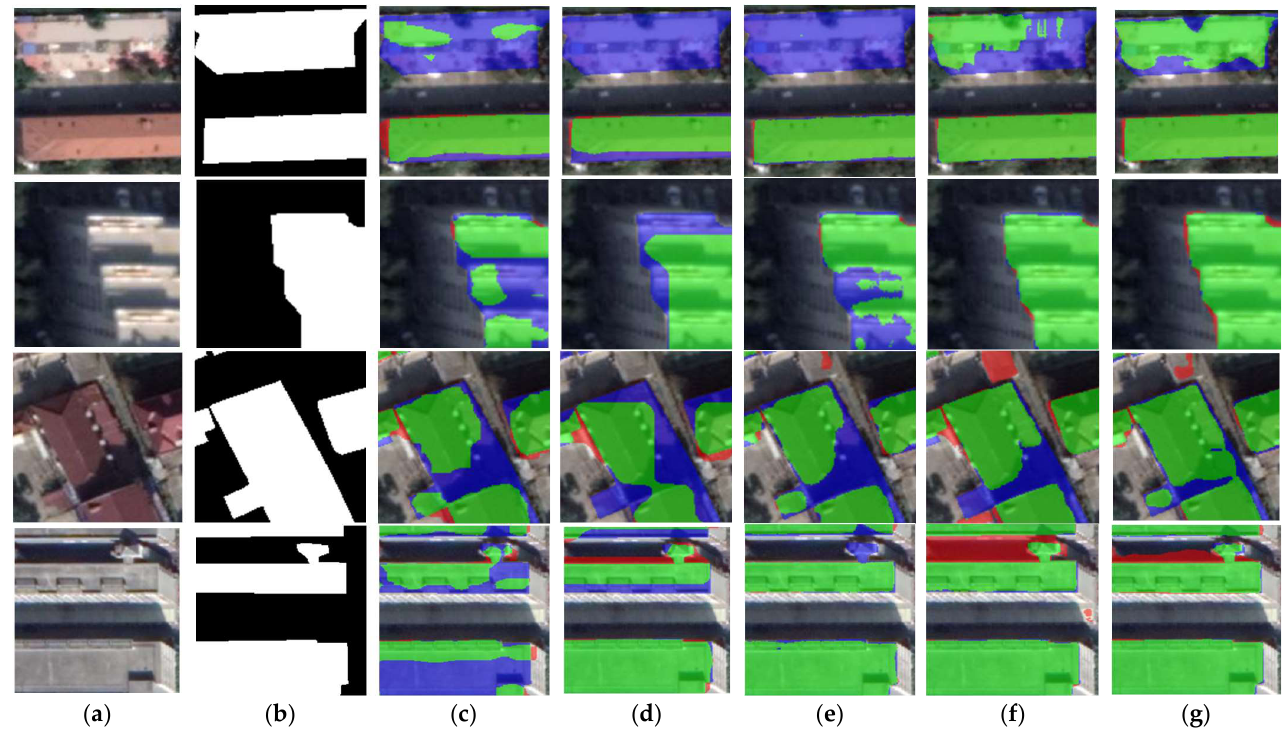
Figure 11. Close-up views of the results obtained by different networks on the CHN dataset. Images and results shown in ( a – g ) are the subset from the selected regions marked in Figure 9a. ( a ) Original image. ( b ) Ground-truth. ( c ) FCN8s. ( d ) DANet. ( e ) SegNet. ( f ) U-Net. ( g ) BGC-Net. Note, in Columns ( b – g ), black, white, green, blue, and red indicate true, false, true-positive, false-negative, and false-positive, respectively.